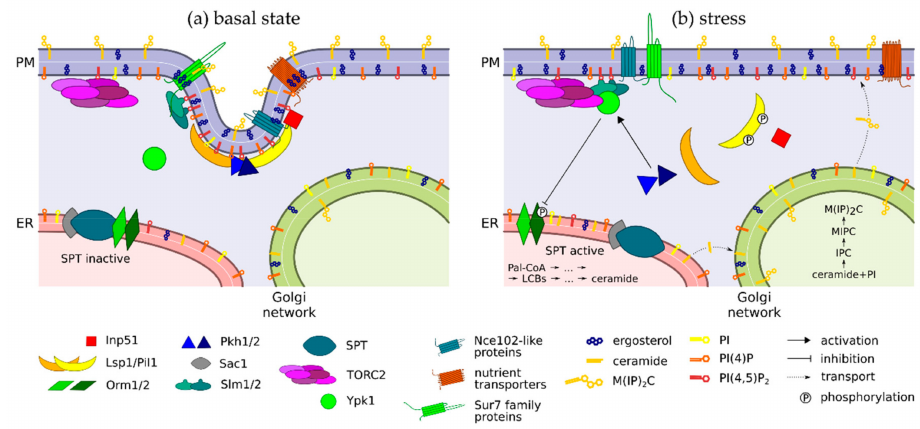
Figure 2. Interplay of MCC / eisosomes and sphingolipid biosynthesis. ( a ) The MCC / eisosome is fully assembled under basal, non-stress conditions. ( b ) MCC / eisosome disassembles following depletion of sphingolipids and / or mechanical stretching of the plasma membrane, resulting in activation of TORC2 and in turn SPT, catalysing the first step of sphingolipid biosynthesis. Short descriptions of proteins involved in this model are listed in Table 1. Used abbreviations: ER—endoplasmic reticulum; IPC—inositol phosphoceramide; LCBs—long chain bases; MCC—membrane compartment of Can1; M(IP) 2 C—mannose-(inositol-P) 2 -ceramide; MIPC—mannosyl-inositol